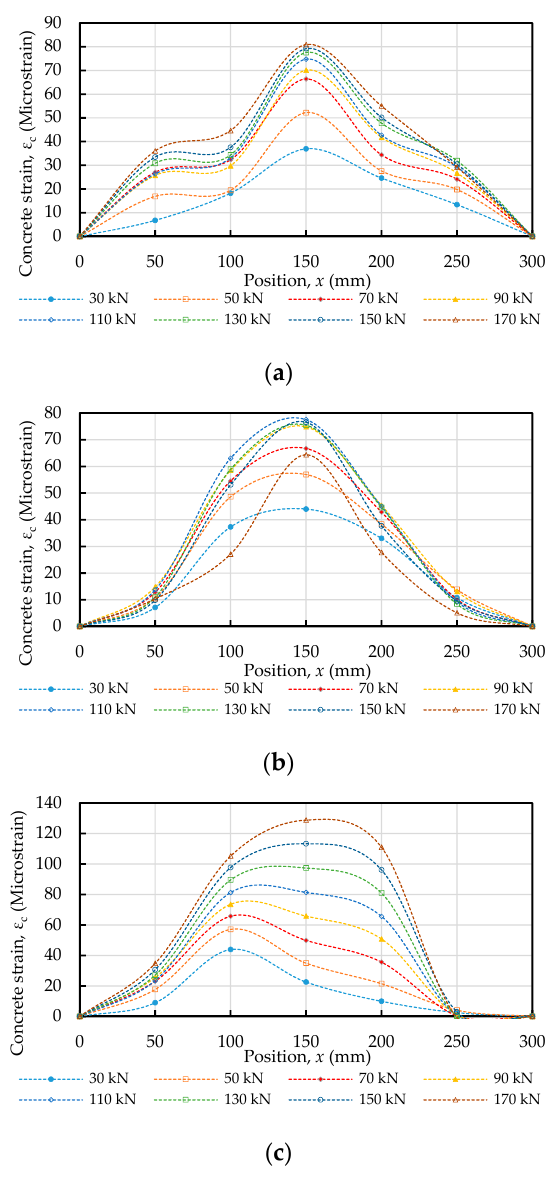
Figure 9. Strain distribution in the concrete subjected to a tensile load: ( a ) C20, ( b ) C40, and ( c ) C60.